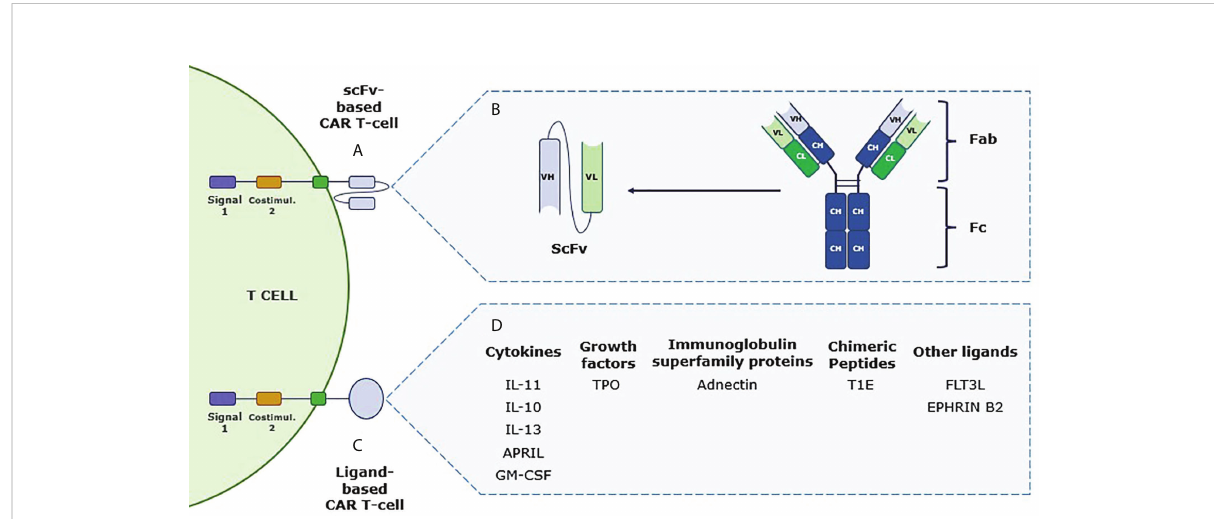
FIGURE 2 Schematic differences between conventional chimeric antigen receptor T (CAR-T) cell and ligand-based CAR-T cell. (A) Second-generation conventional CAR-T cell structure, including T-cell activation domain (signal 1) and costimulatory regions. The recognition domain of this CAR- T is composed of the single-chain variable fragment (scFv) that allows direct interaction with the tumor-associated antigen to trigger the antitumor response. (B) Schematic representation of the different chains that form an antibody and how the scFv domain is obtained from the variable heavy and light chains of a monoclonal antibody to be used in the CAR-T structure. (C) Structure of a second-generation ligand-based CAR-T cell that shares the same domains as mentioned with scFv-based CAR-T cells but incorporating a ligand as a target recognition domain. (D) Immune cytokines, growth factors, immunoglobulin superfamily proteins, and chimeric peptides, among others, are listed as potential molecules to be used as ligand-based CAR-T cell recognition domains (see some abbreviations in Table 1).